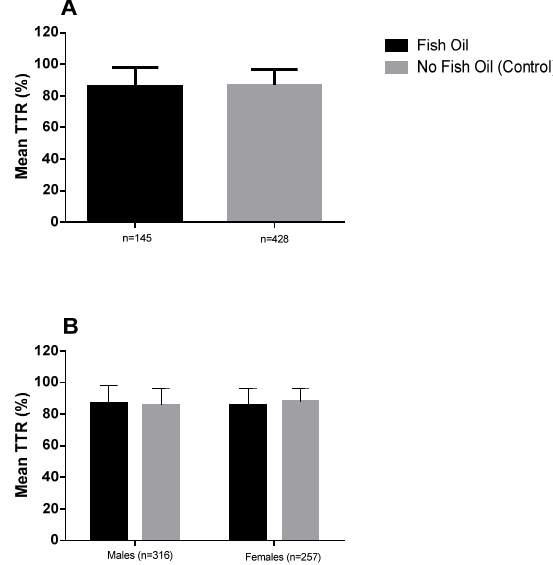
Figure 1. Mean TITR for ( A ) fish oil versus no fish oil supplementation; and ( B ) gender comparison for fish oil versus no fish oil supplementation. Data is shown as mean and standard deviation; males ( n = 316), females ( n = 257). Table 2. Bleeding incidence per person ‐ year for (A) supplement and control group patients, and (B) gender comparisons for supplement and control groups.